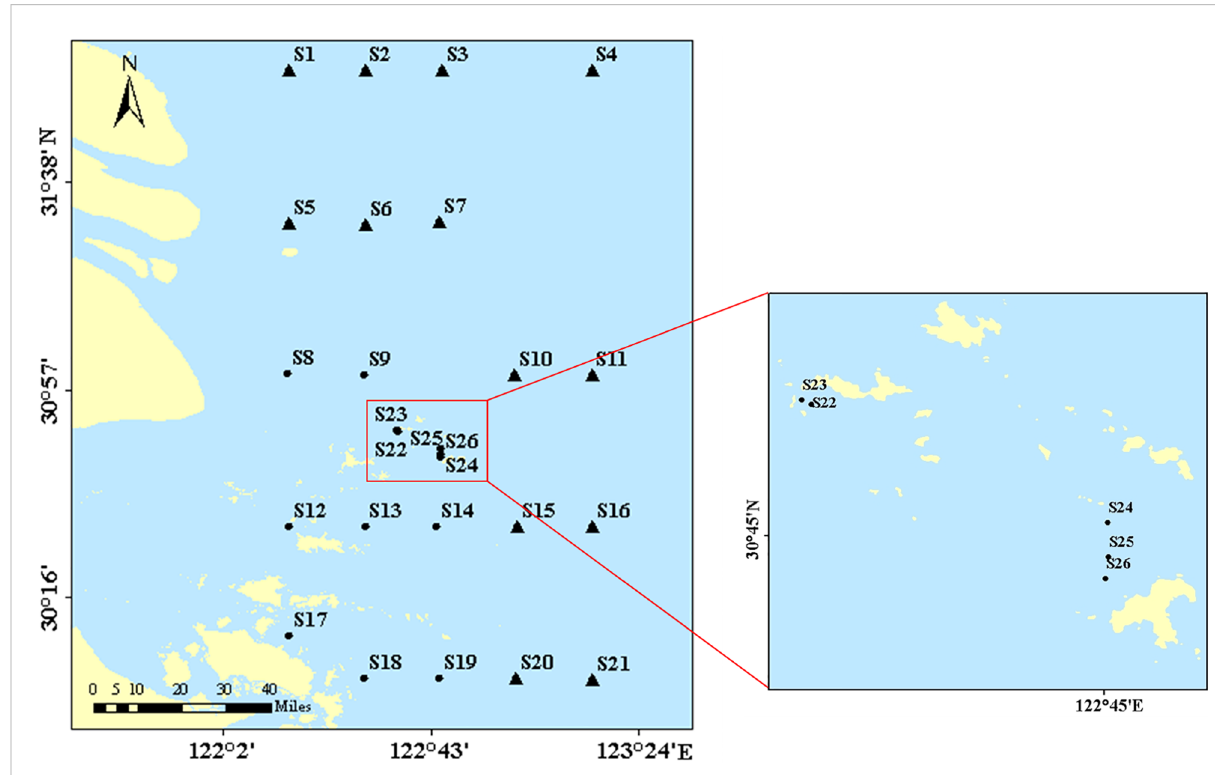
FIGURE 1 Sampling stations in this work. The small plot on the right indicates the sites with aquaculture impact (mussel aquaculture